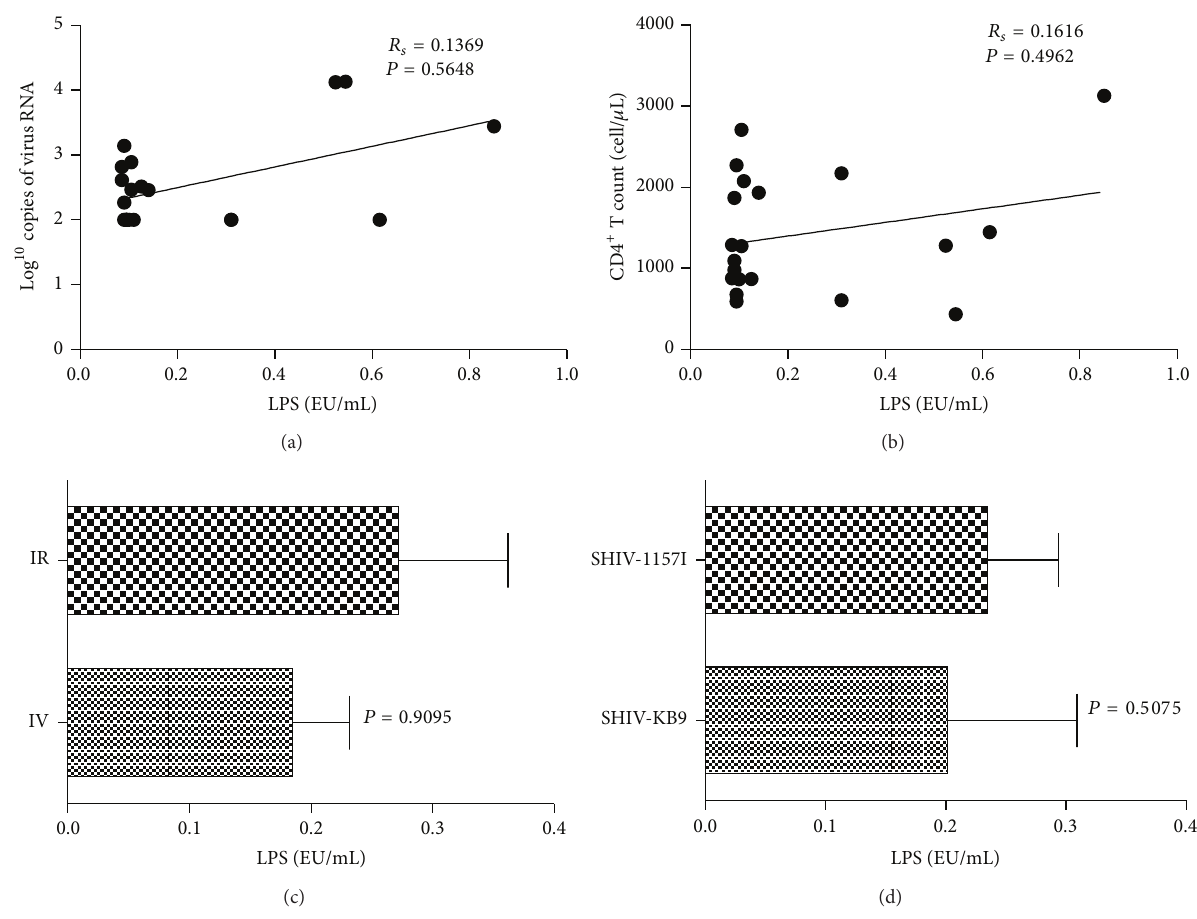
Figure 1: Lipopolysaccharide (LPS) levels are not associated with plasma viral load (PVL), CD4 + T cells, route of infection, or virus strain. Peripheral LPS levels of infected Chinese macaques did not correlate with (a) PVL (Spearman correlation test, 𝑅 𝑠 = 0.1369 ), (b) peripheral CD4 + T cells (Spearman correlation test, 𝑅 𝑠 = 0.1616 ), (c) infectious route (two-sided nonparametric Mann-Whitney 𝑈 test, 𝑃 = 0.9095 ), or (d) virus strain (two-sided nonparametric Mann-Whitney 𝑈 test, 𝑃 = 0.5075